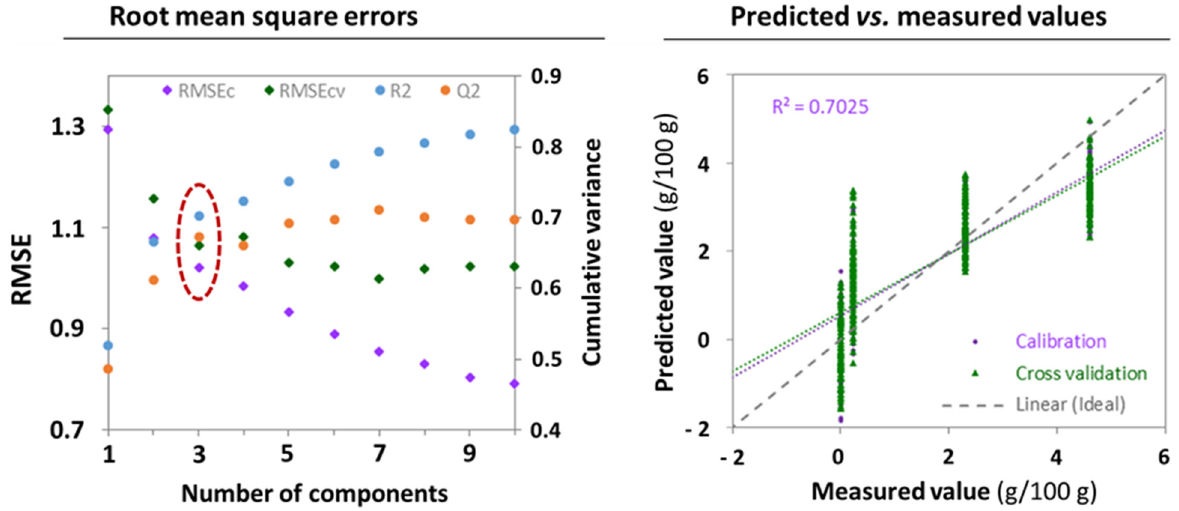
Figure 4. Orthogonal partial least squares regression model for cornstarch in dry-blended skimmed milk powders from spectra acquired with the device A : Left panel: Root mean square errors (calibration and cross-validation) and cumulative variances (explained and predicted) as a function of model size (number of total components). Right panel: predicted versus measured values on cross-validation (model fitness).